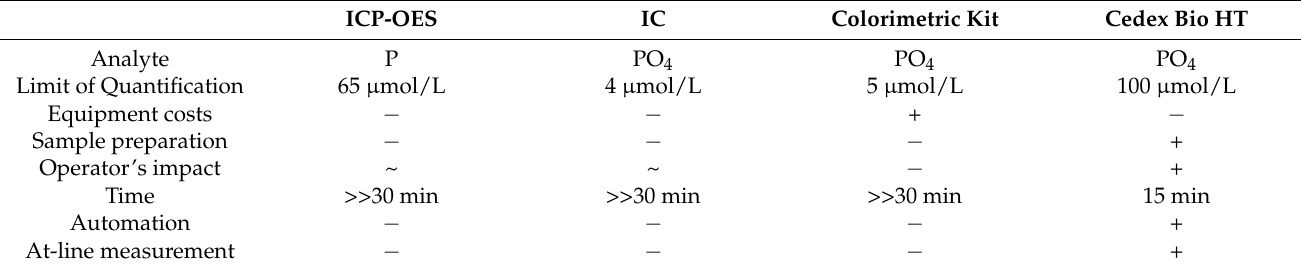
Table 6. Overview of investigated analytical methods for PO 4 monitoring.